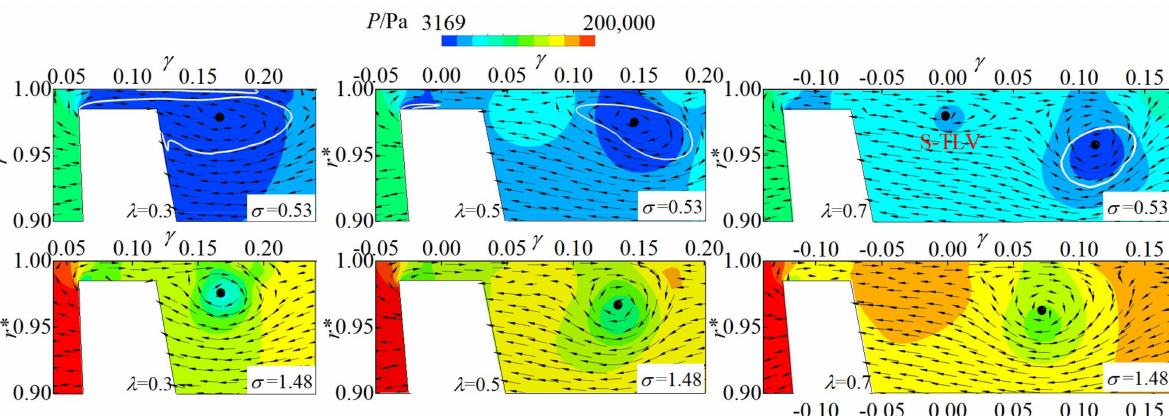
Figure 14. Comparison of the pressure distributions on the three planes for the cavitating case ( upper ) and non-cavitating case ( lower ) (the solid point is the vortex center, and the white line represents the isovalue of the vapor volume fraction ( α v = 0.1)).